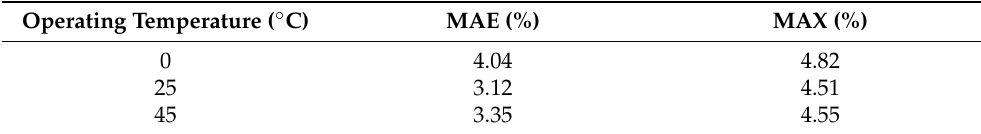
Figure 3. Results of battery model: ( A ) current profile, ( B ) comparison with simulation voltage and measured voltage, ( C ) cell temperature. Table 1. Accuracy of terminal voltage based on the battery